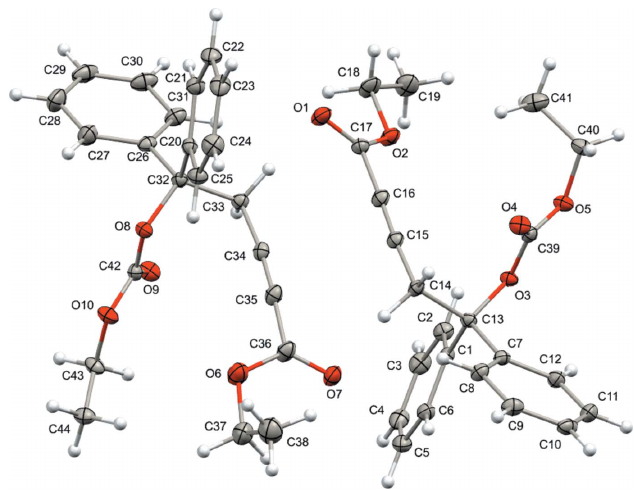
Figure 1 The title molecule with 50% probability ellipsoids. The minor disorder component for the C20 molecule is not